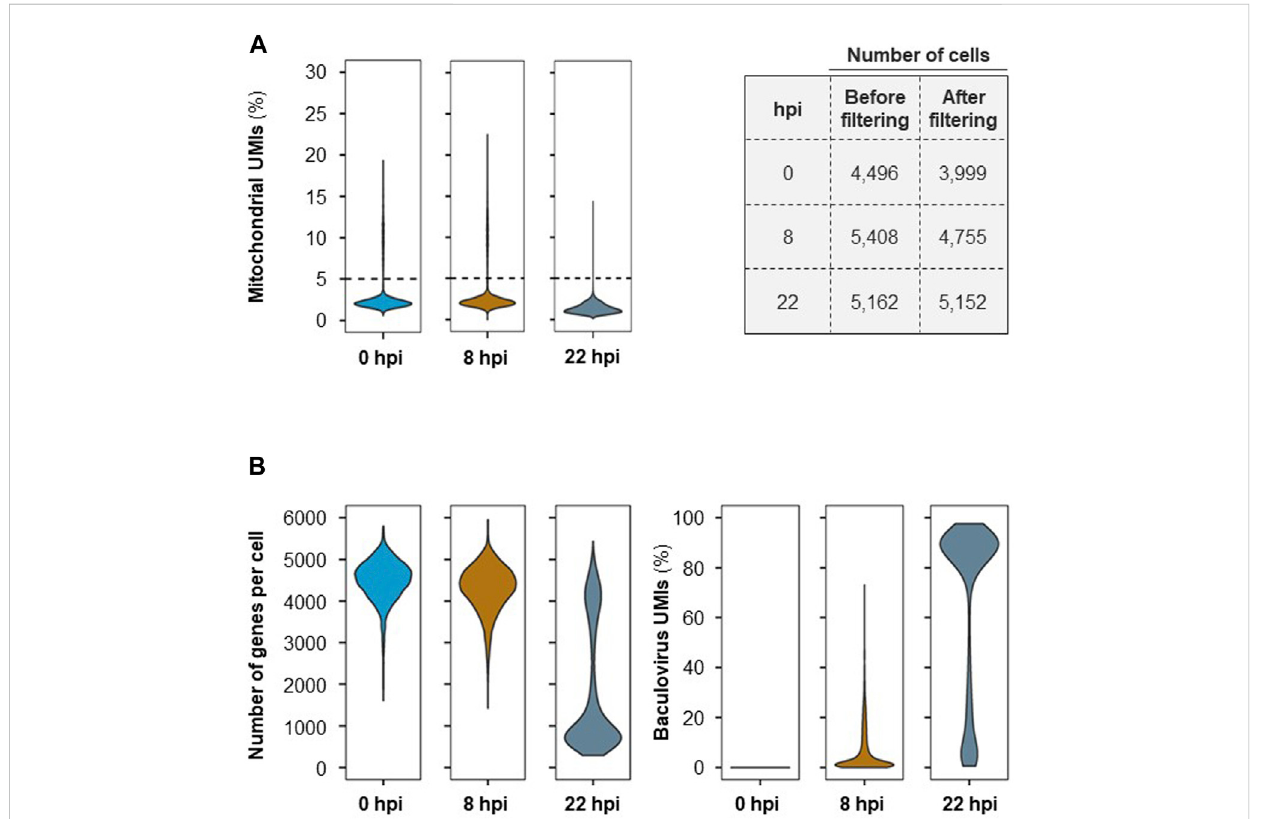
FIGURE 2 Single-cell RNA-seq quality control. (A) Mitochondrial UMIs per cell (on the left) and number of cells before and after fi ltering per UMIs originating from mitochondrial genes ( > 5%) (on the right). (B) Number of genes identi fi ed per cell and percentage (%) of cells containing UMIs originating from baculovirus genes at each time point after cell fi